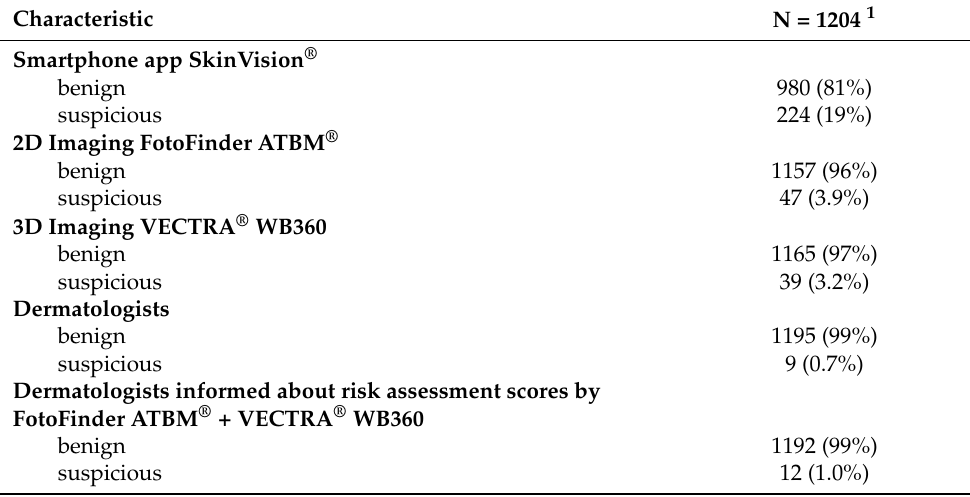
Table 2. Risk assessments of 1204 pigmented skin lesions by the smartphone app SkinVision ® , 2D imaging FotoFinder ATBM ® , 3D imaging Vectra ® WB360, dermatologists, and dermatologists in combination with knowledge of FotoFinder ATBM ® and Vectra ® WB360